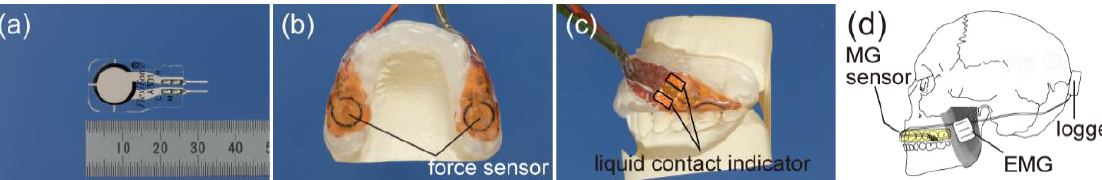
Figure 1. ( a ) Piezoresistive force sensor (FlexiForce); ( b ) occlusal surface; ( c ) side view of the mouth guard (MG) sensors; and ( d ) MG sensor and electromyogram (EMG) settings.